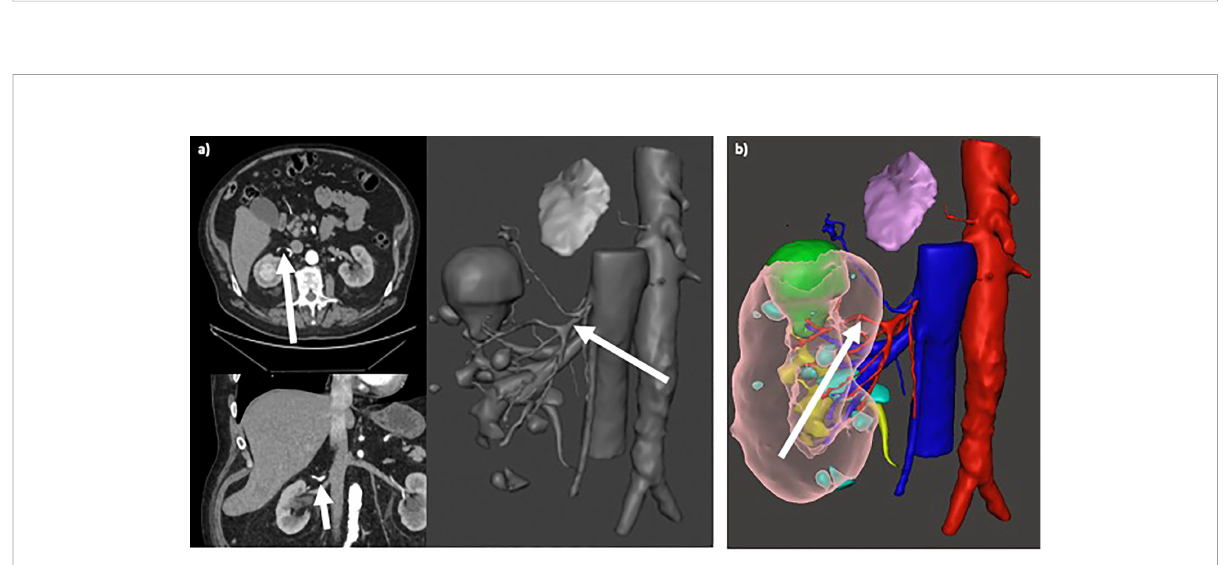
FIGURE 4 (A) Selective clamping of primary arterial branching (arrows in axial/coronal views and in 3D rendering), resulting from preoperative planning based on standard 2D CT imaging; (B) Super-selective clamping of tertiary arterial branching (arrow), resulting from preoperative planning based on 3D